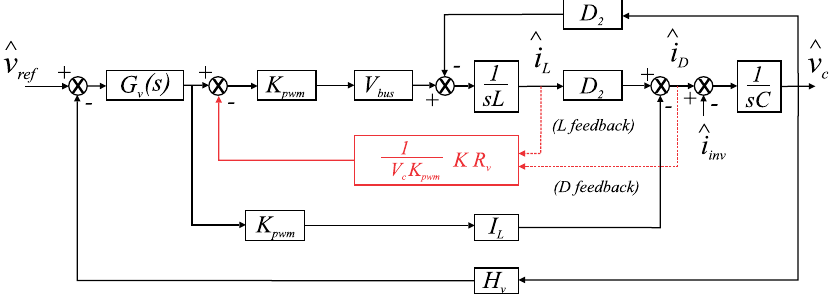
Figure 23. Virtual resistance